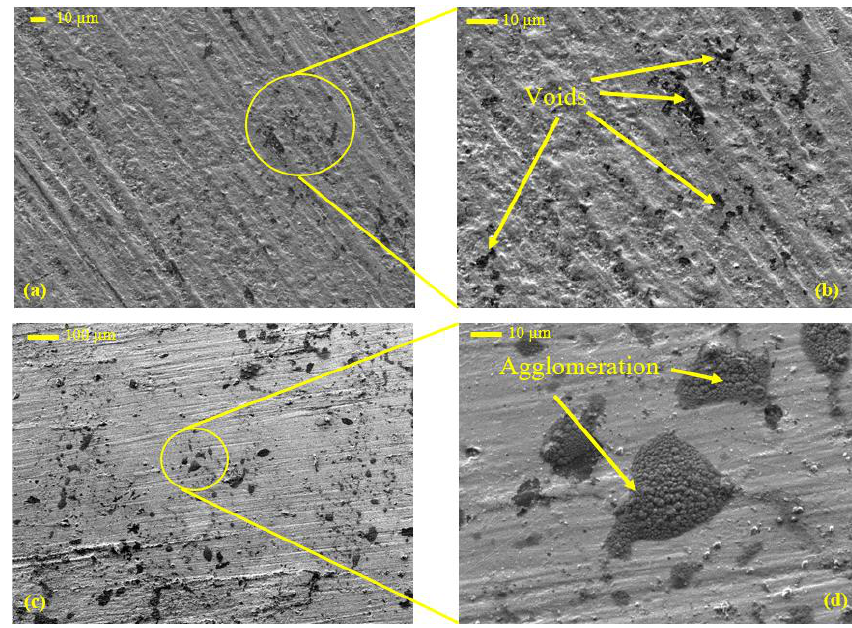
Figure 9. SEM images of the surfaces of ( a , b ) pure PLA and ( c , d ) PLA-DP10.